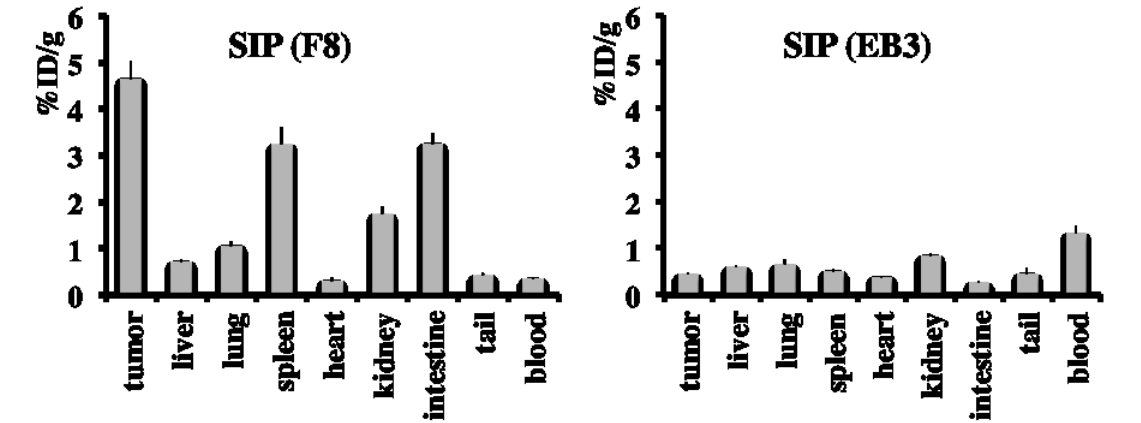
Figure 5. Radioiodinated preparations of SIP(F8) (left) and SIP(EB3) (right) were injected into nude mice, bearing subcutaneously-grafted U87 tumors. Twenty-four hours after intravenous administration, SIP(EB3) failed to localize to the neoplastic lesions in vivo . Results are expressed as percentage of injected dose per gram of tumor tissue